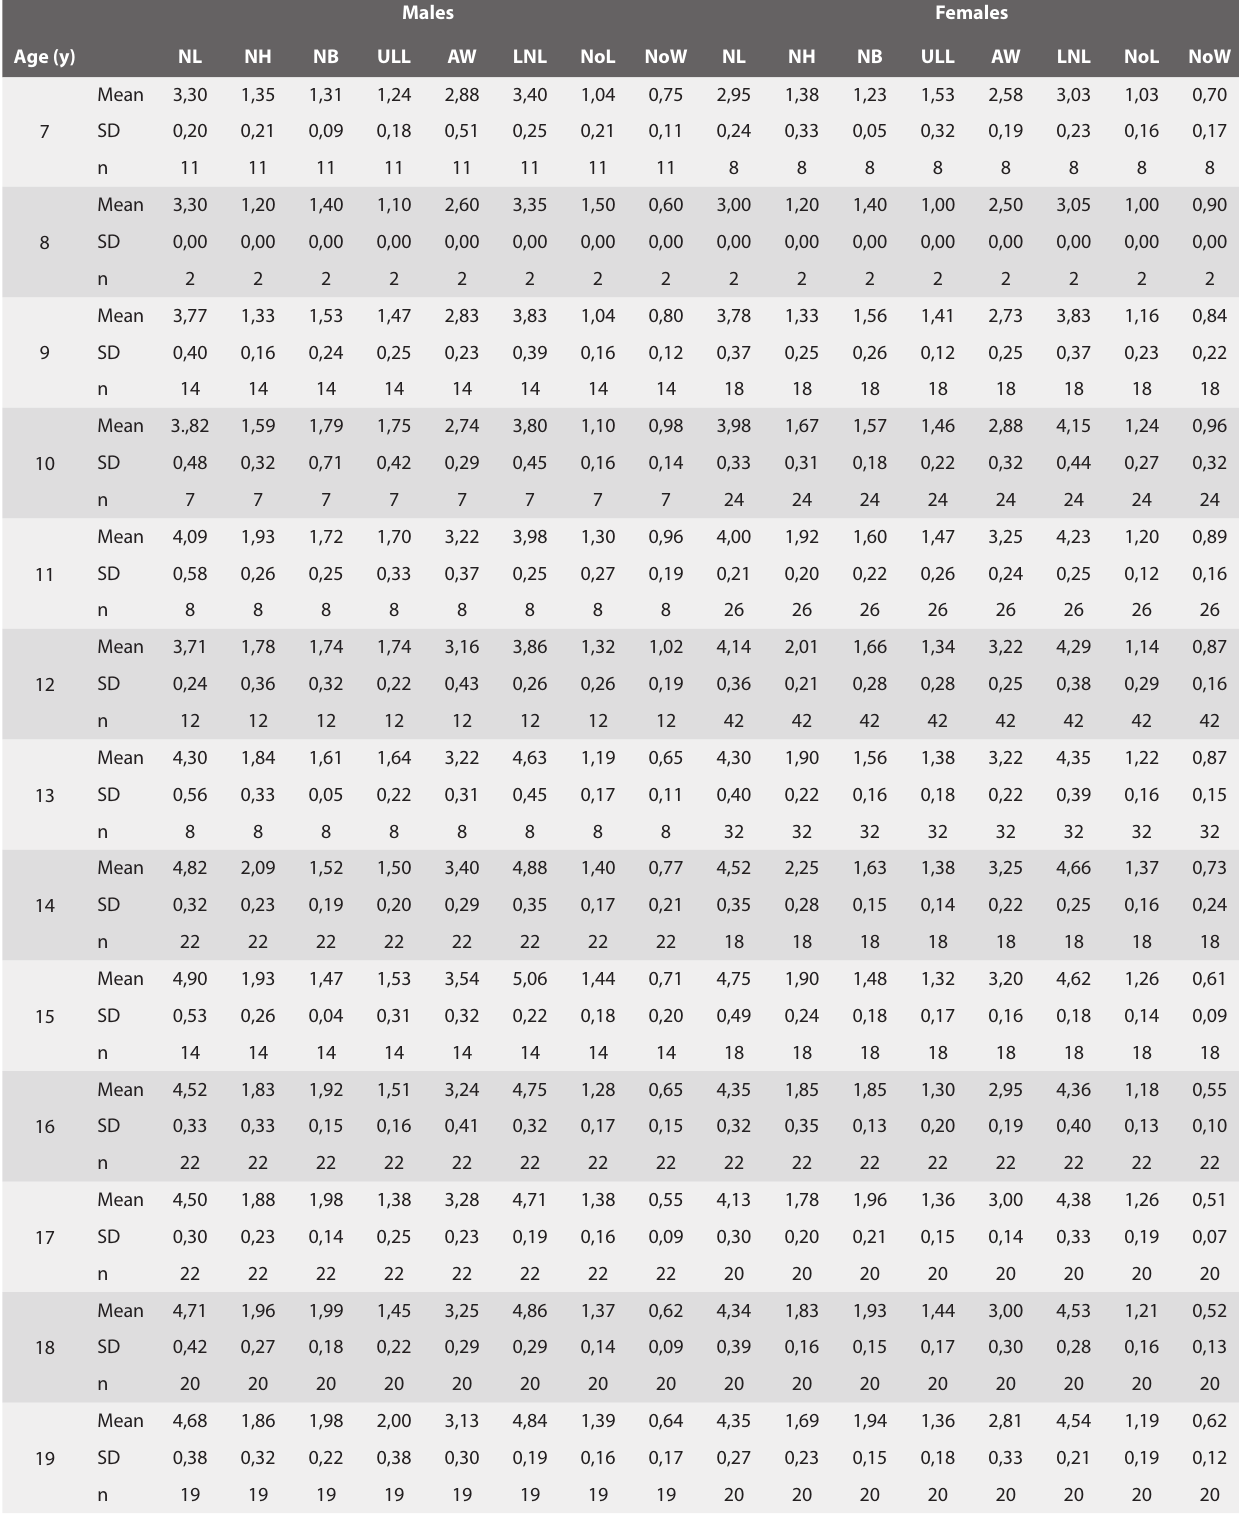
Table 1. Descriptive statistics of anthropometric parameters in males and females. Males